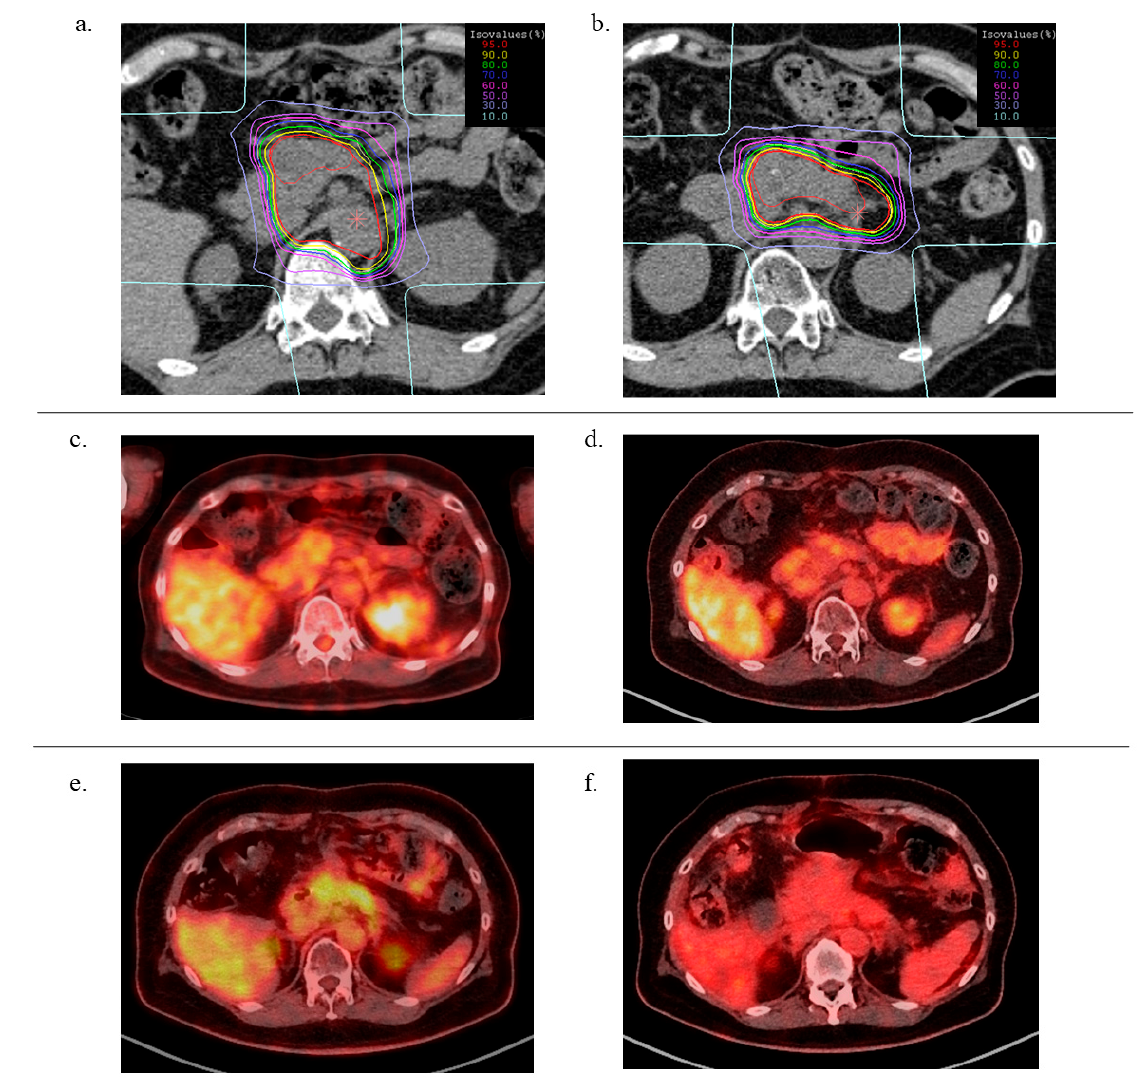
Figure 1. Typical case presentation: 55-year-old female patient with pancreatic body cancer. ( a ) Dose distribution of 1st CIRT, ( b ) dose distribution of 2nd CIRT, ( c ) fluorodeoxyglucose (FDG)-positron emission tomography (PET) computed tomography (FDG-PET/CT) image before 1st CIRT, ( d ): FDG-PET/CT image at 3 months after 1st CIRT, ( e ): FDG-PET/CT image at the recurrence after 1st CIRT, ( f ): FDG-PET/CT image at 3 months after 2nd CIR T.